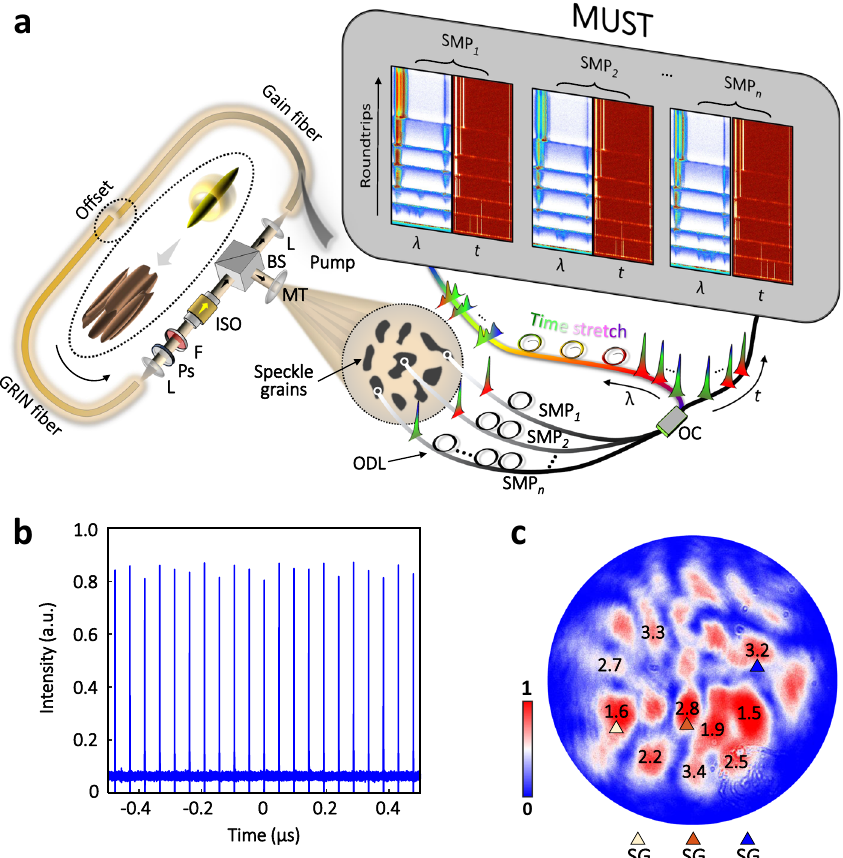
Fig. 1 Schematic diagram of the real-time MUST measurement system and typical characteristics of the 3D soliton laser. a Schematic diagram of the MUST measurement system. A spatiotemporal mode-locking (STML) multimode fi ber laser is utilized for the study of 3D soliton dynamics. The state of polarization of the laser cavity is adjusted by half-wave and quarter-wave plates (Ps). The STML operation is realized by an intensity-dependent transmission mechanism 14 . The laser beam (i.e., signal) is extracted by a beam splitter (BS), after which it is enlarged by a magni fi cation telescope (MT, 5×) and visualized by the MUST measurement system. In the MUST system, real-time spectral-temporal signals from multiple speckle grains are individually collected by different single-mode probes (SMPs). The collected signals are then temporally multiplexed using optical delay lines (ODLs). The multiplexed signal is split into two branches, one of which is directly detected ( t ). The other branch is launched to a time-stretch unit for real-time spectroscopy ( λ ). F fi lter, ISO isolator, L lens. OC optical coupler, SG speckle grain. b Typical pulse train of the STML laser. c Distribution of the pulsewidth (uncompressed) over the speckle grains. Unit: